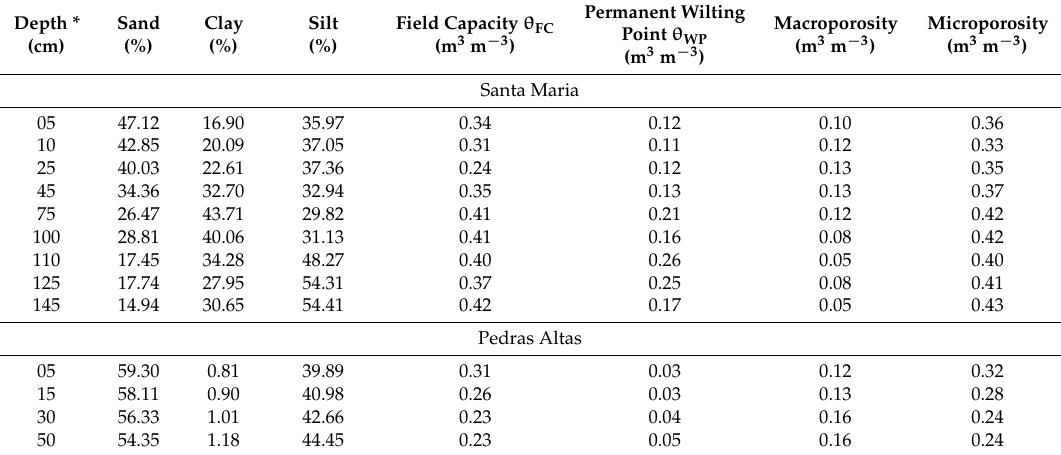
Table 1. Physical properties of the soil at the experimental sites in the SMA and PAS sites in southern